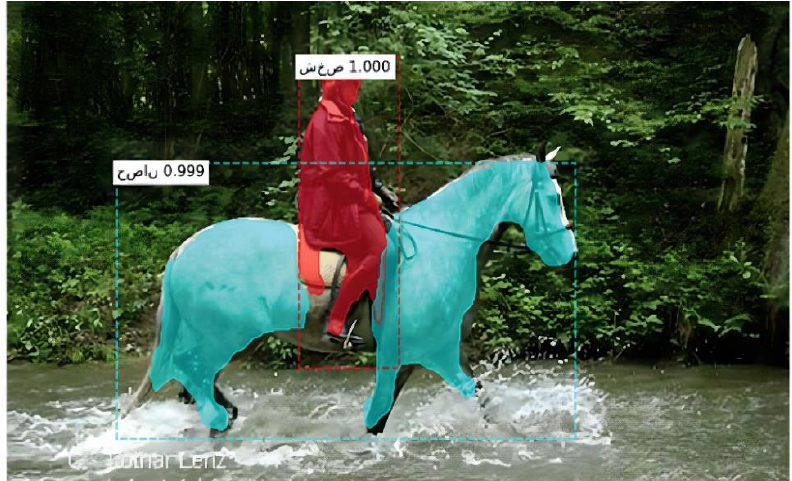
(cid:145)(cid:9) (cid:109)(cid:25)(cid:17) (cid:133) means person,